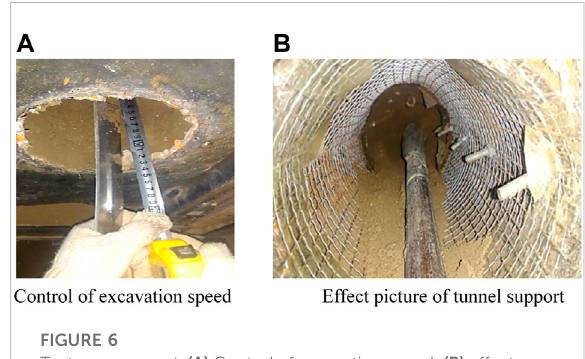
FIGURE 6 Test arrangement. (A) Control of excavation speed; (B) effect picture of tunnel